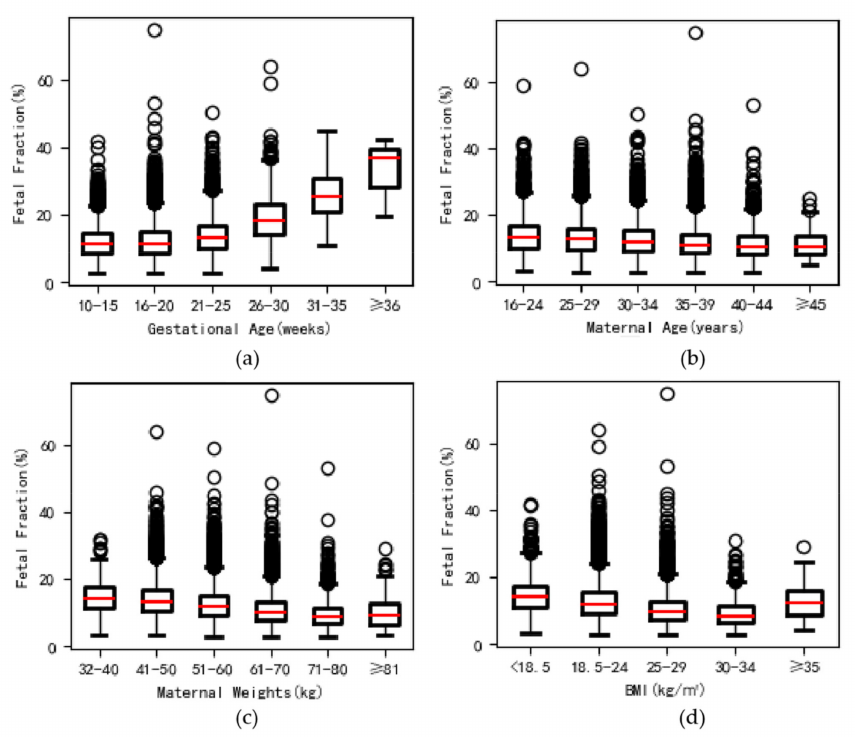
Figure 2. Comparison of fetal fraction with gestational age, maternal age, weight and body mass index (BMI). ( a ) A significant positive relationship between fetal fraction and gestational age (y = 0.342x + 6.555, r = 0.214, p < 0.001). ( b ) A significant change in fetal fraction was observed with maternal age (y = − 0.146x + 17.420, r = − 0.168, p < 0.001). ( c ) Fetal fraction decreased gradually with maternal weights (y = − 0.447x + 60.764, r = − 0.263, p < 0.001). ( d ) Fetal fraction decreased gradually with BMI (y = − 0.409x + 21.726, r = − 0.261, p <